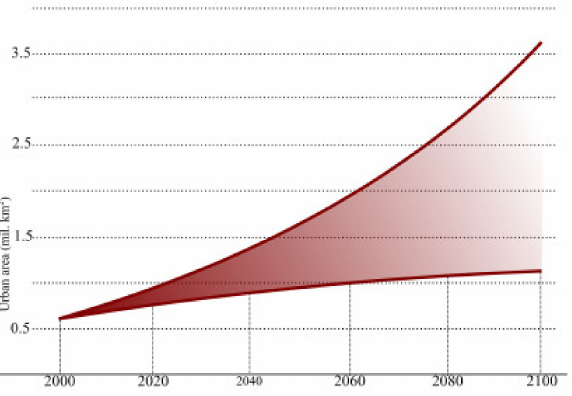
Figure 4. Projected growth of urban areas between 2000 and 2100. Source: https://population.un. org/wup/Maps/ (accessed on 2 August